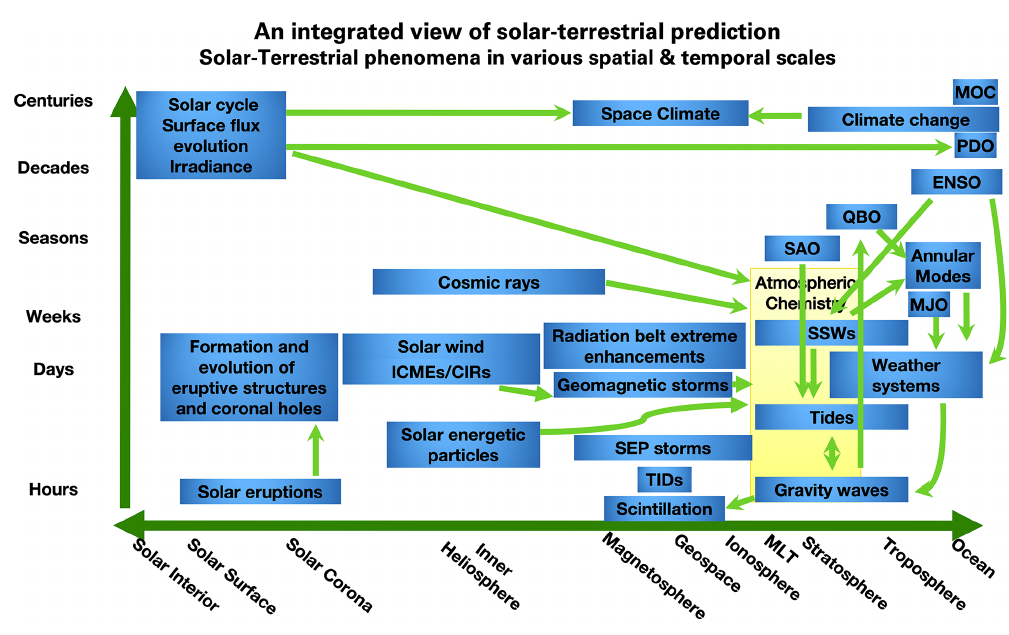
Figure 1. An integrated view of solar–terrestrial phenomena in various spatial and temporal